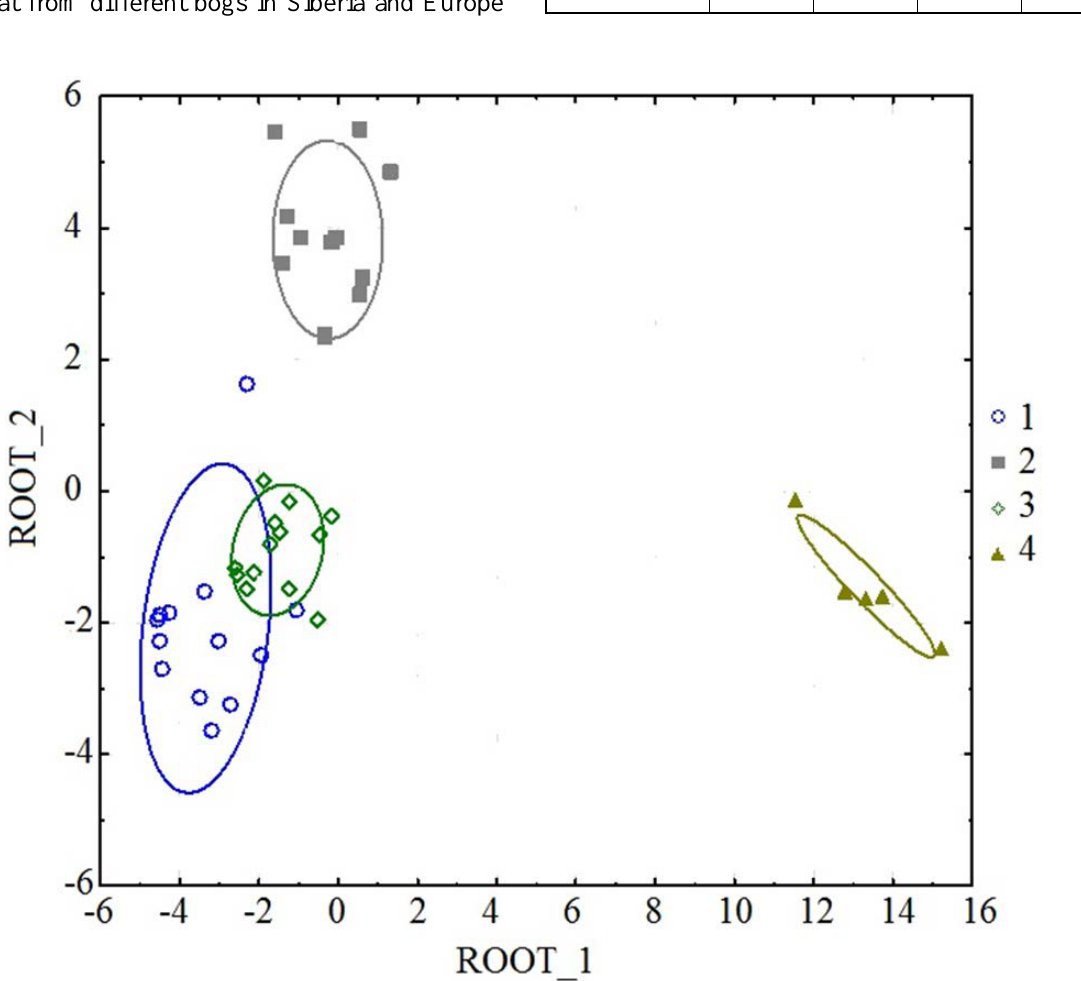
Figure 6. The results of discriminant analysis for the Zn, Cu, Pb and Cd content of plants and peat. 1: Vasyugan Mire, pristine sites; 2: Vasyugan Mire, drained sites; 3: terrace of the Ket River, pristine sites; 4: terrace of the Ket River, drained